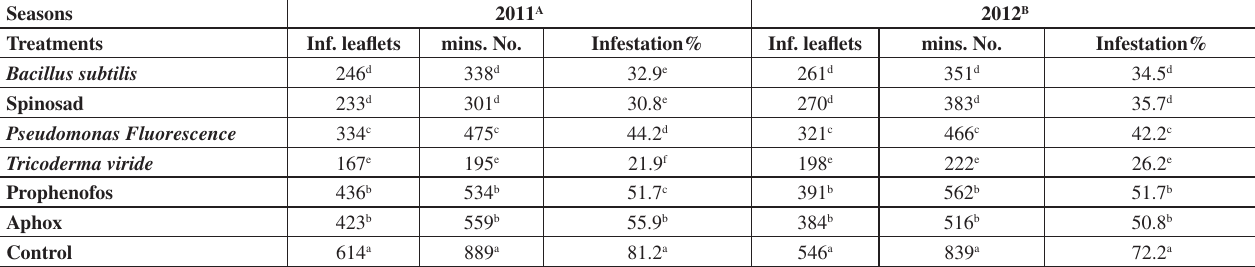
Table (1): The effect of the four bio- treatments compared to chemical insecticides against T. absoluta during 2011 and 2012 seasons. Seasons